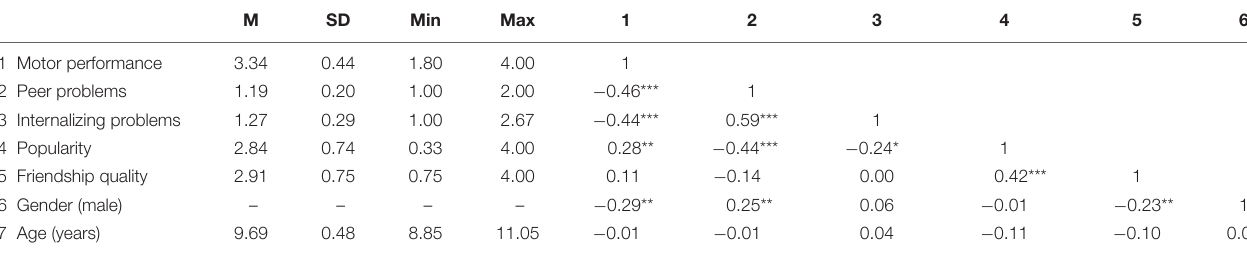
TABLE 1 | Means, standard deviations, ranges, and intercorrelations between main variables ( N = 189). M SD